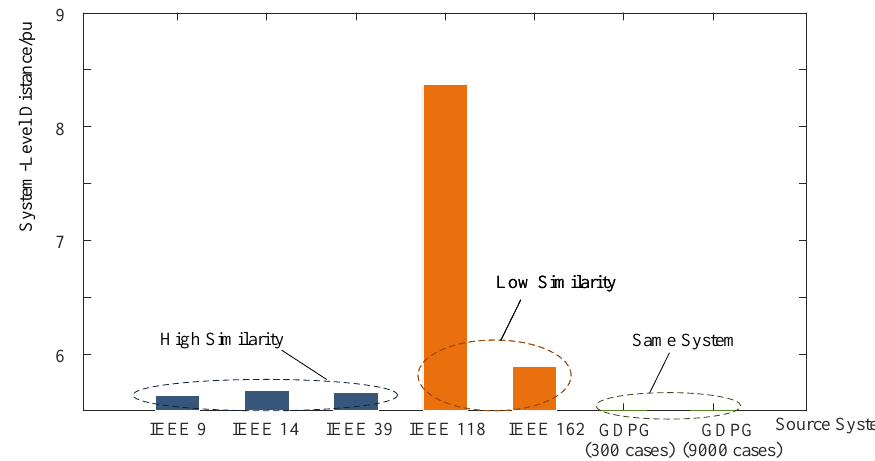
Figure 6. Distances between different source systems and the target